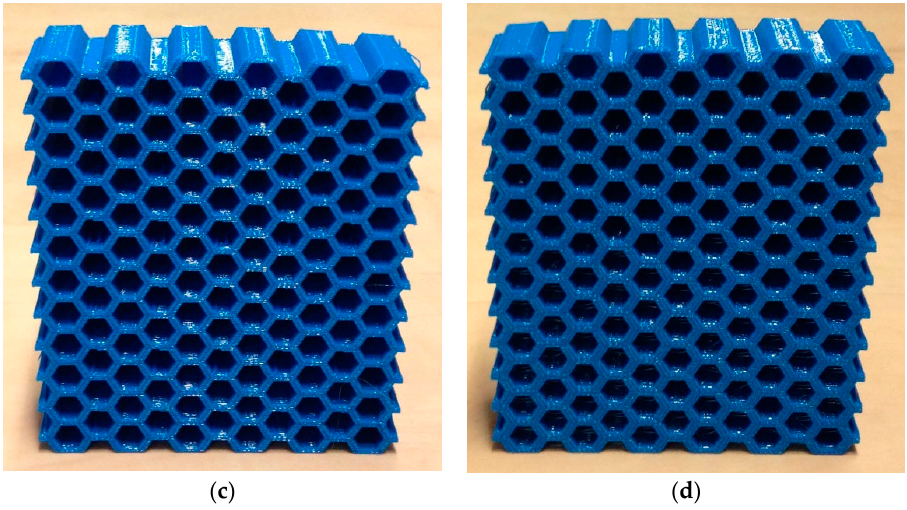
Figure 1. The manufactured hexagonal honeycombs with ( a ) t / l = 0.09; ( b ) t / l = 0.18; ( c ) t / l = 0.27; and ( d ) t / l = 0.36.